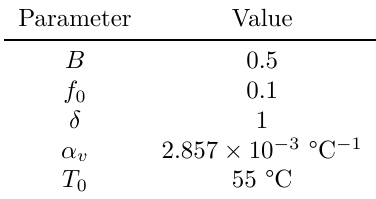
Table 2. Used material parameters. Values taken from